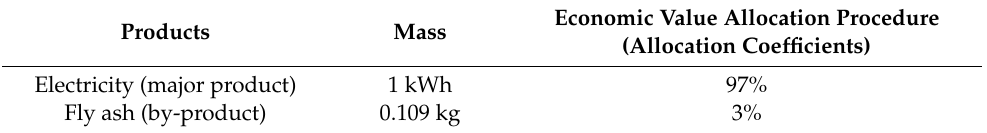
Table 3. Allocation procedure of fly